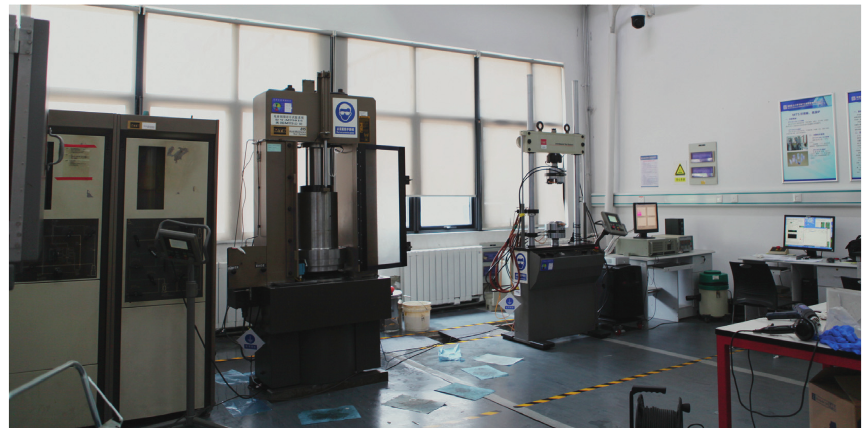
Figure 3: MTS815.02 electrohydraulic servo rock mechanics test